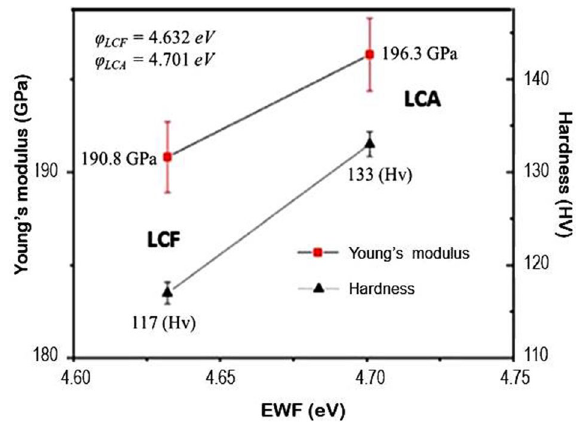
Figure 3. Relationship between mechanical property and overall